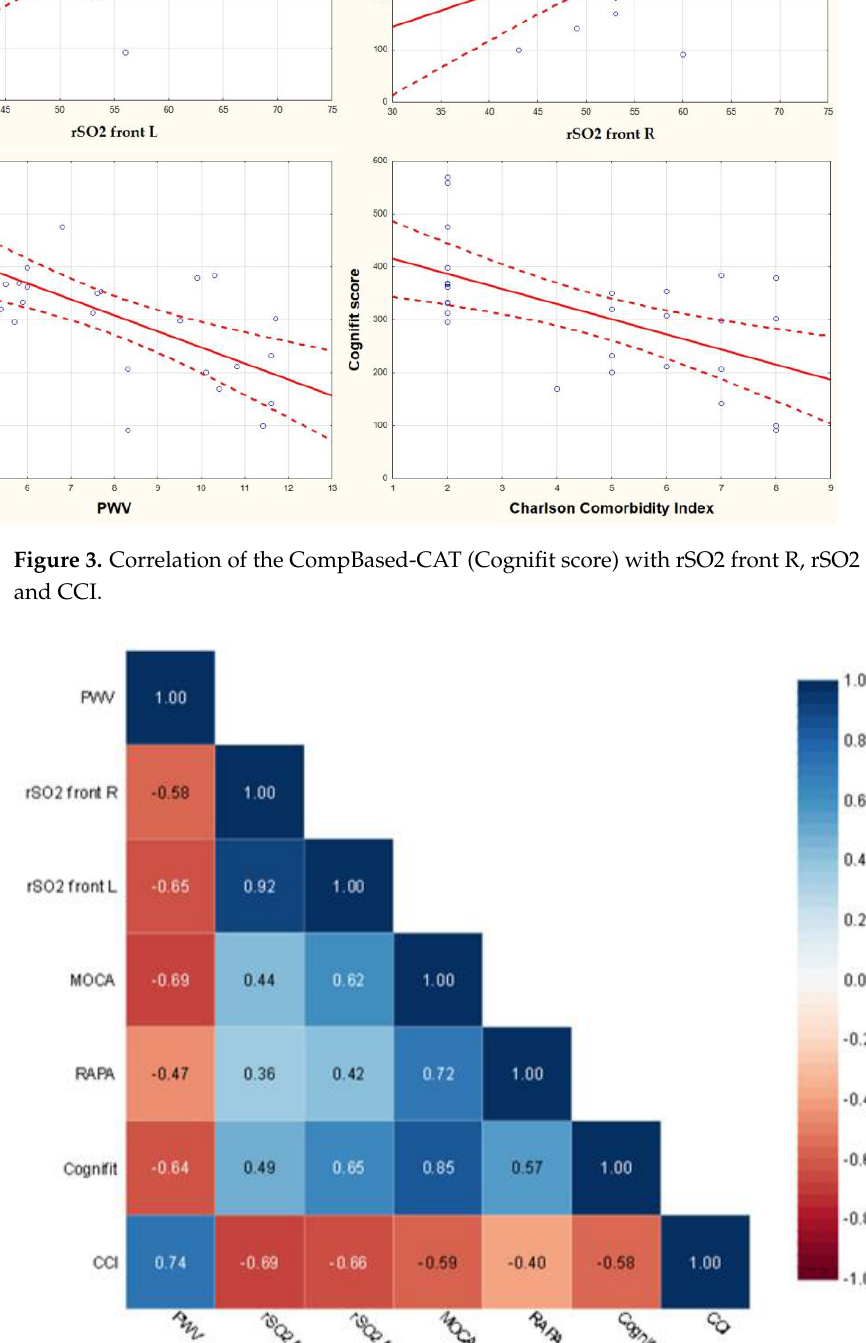
Figure 4. Correlation